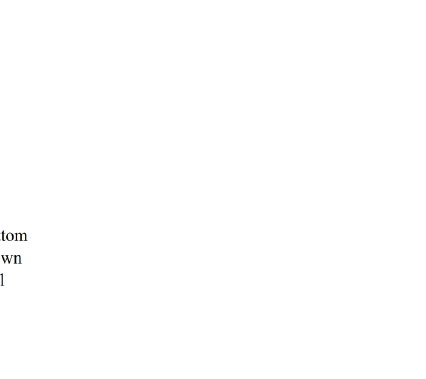
Figure 18. The range variation of the loosened zone (pressure arch) with the increasing